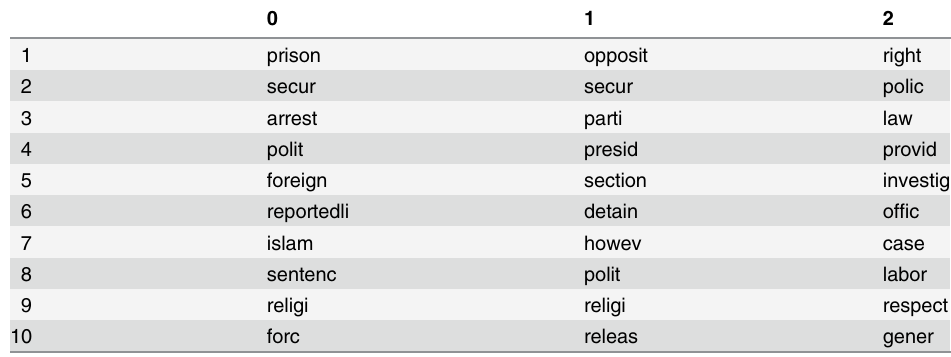
Table 9. Ten most important words for the CIRI Freedom of Foreign Movement and Travel variable. 0 1